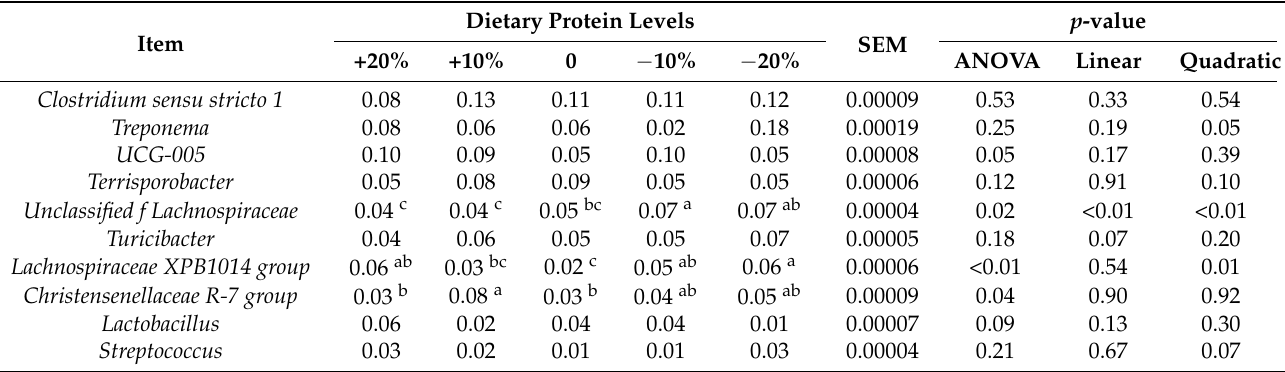
a,b,c Values ( n = 6) within a row with different lowercase letters differ significantly ( p < 0.05) by the Kruskal–Wallis